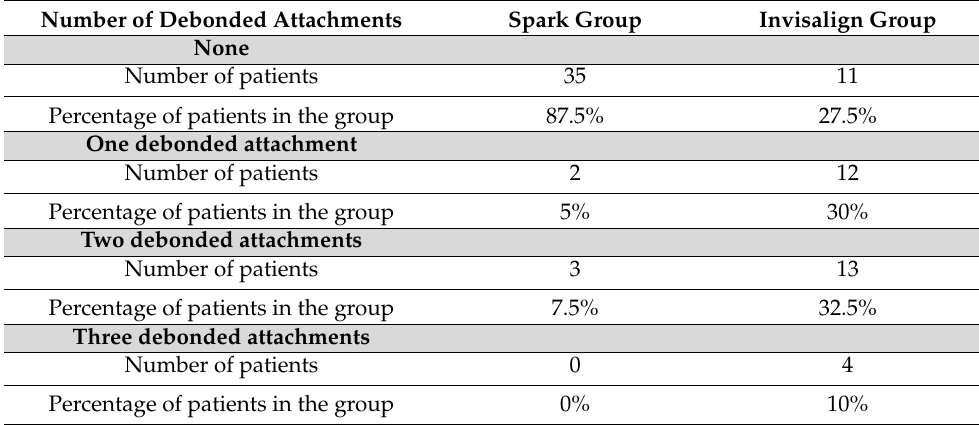
Table 2. Frequency distribution of attachment bonding failure in the two